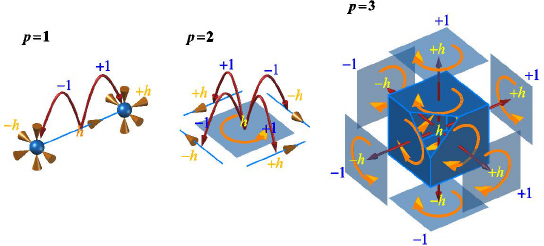
Figure 56: Spreading the weight of one p -cell on its